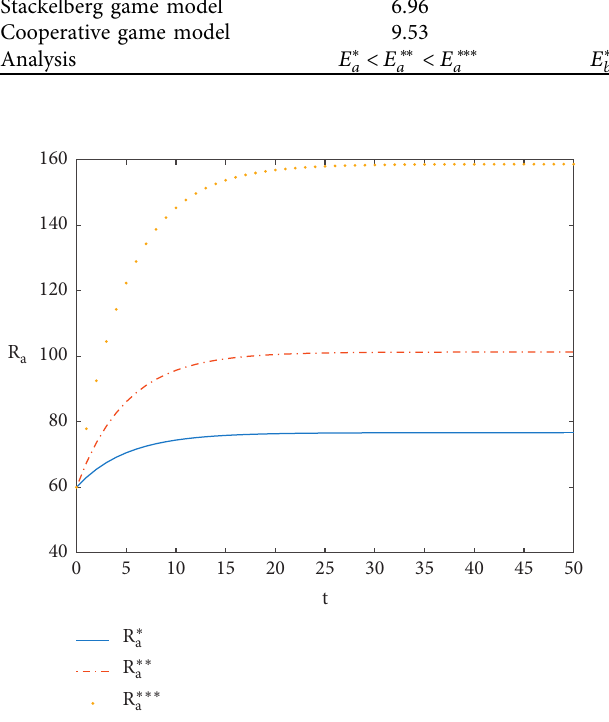
Figure 1: The environmental pollution control level of Local-gov A.